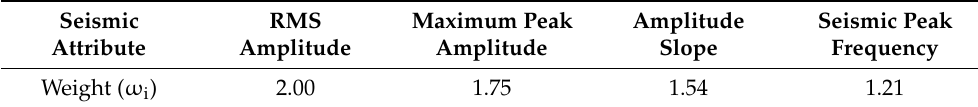
Table 1. Computed weights of four selected seismic attributes.